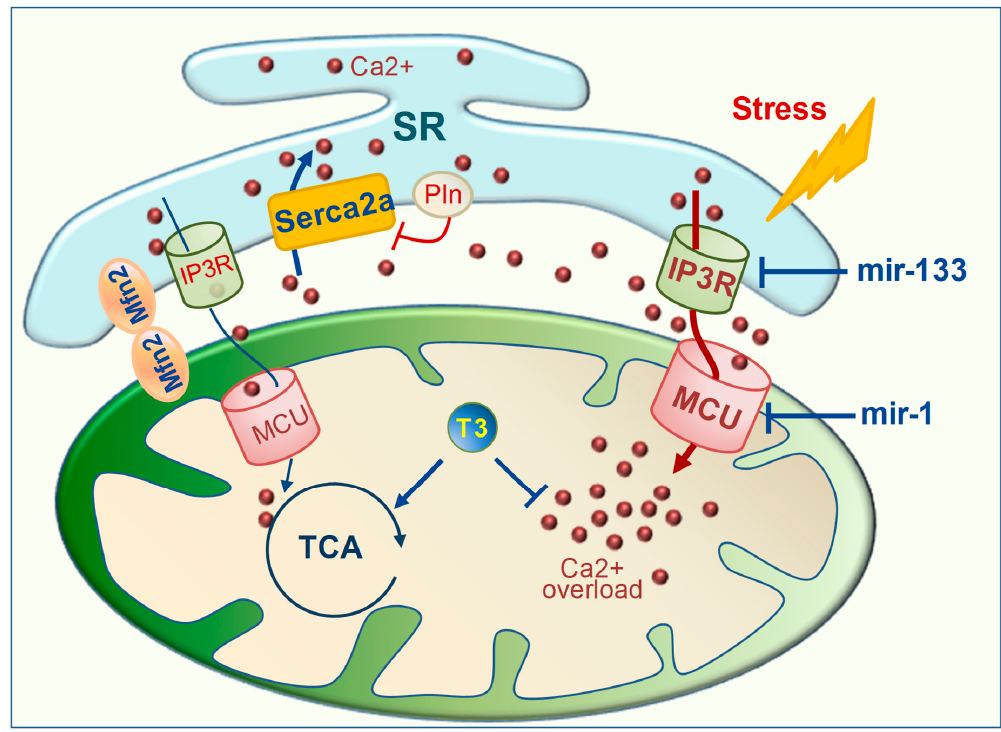
Figure 2. Effect of T3 on Ca 2+ handling. Under stress conditions, Ca 2+ dis-homeostasis is determined by a reduced function of the Serca2a channel and increased activity of the Serca2a inhibitor Pln. Excessive activation of IP3R and MCU channels contributes to mitochondrial Ca 2+ overload, mitochondrial dysfunction, and cell death. T3 limits mitochondrial Ca 2+ overload and favors energy production through several mechanisms: (1) promoting Ca 2+ uptake within the SR by up-regulating the Serca2a channel and down-regulating Pln; (2) enhancing the expression level of mir-1 and mir-133, established suppressors of IP3R and MCU, respectively; (3) stimulating the activation of the Ca 2+ dependent TCA enzymes by Mfn2-dependent tethering of the mitochondrial membrane and SR, thus prompting the formation of Ca 2+ microdomains. (IP3R: inositol 1,4,5-trisphosphate receptors; MCU: mitochondrial calcium uniporter; Mfn2: mitofusin2; Pln; phospholambam; Serca2a: SR Ca 2+ ATPase 2a; SR: sarcoplasmic reticulum; TCA: tricarboxylic acid cycle).